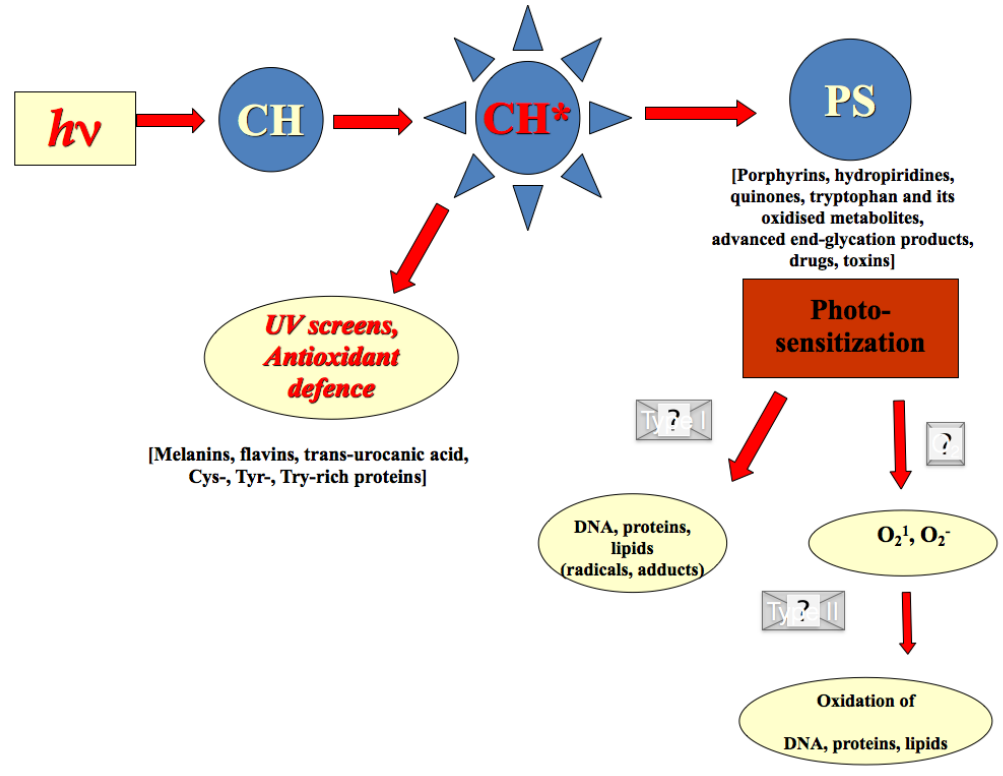
Figure 6. Endogenous photo-protectors and photo-sensitisers within human skin. Quantum of solar energy (h ν ) is absorbed by endogenous chromophore (CH), which becomes excited (CH*) and highly reactive either directly with DNA and proteins (type I reaction) or it reacts first with molecular oxygen (type II reaction) converting it in singlet oxygen, thus initiating non-enzymatic oxidation reaction. Examples of endogenous cutaneous photo-protectors and photo-sensitisers are in the brackets.